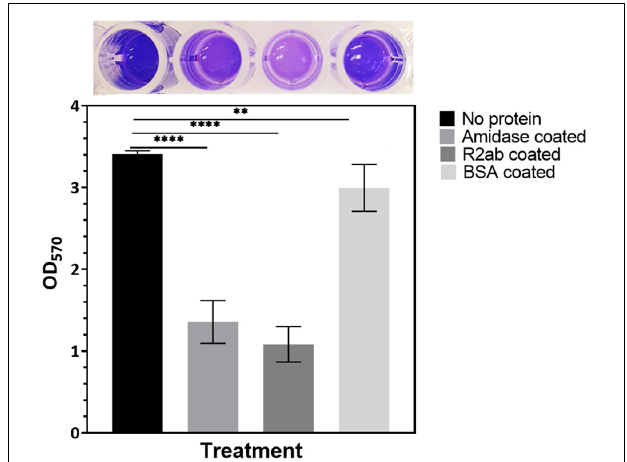
FIGURE 1 | The effect of protein treatment on biofilm formation. Wells were pre-coated with either no protein (control), amidase, R2ab, or BSA, followed by growth conditions favoring biofilm formation, which was monitored by crystal violet staining and measurement of absorbance at 570 nm. The BSA-coated plate showed only a slight reduction in biofilm growth relative to no treatment, but plates treated with amidase and R2ab domains show a much larger reduction. A typical row from a stained, 96-well plate is shown above each corresponding column to display the results of crystal violet staining. The error bars for each data point represent the standard error of the mean for N = 8 samples. A one-way ANOVA test [ F (3,28) = 217.2, p < 0.0001] with Tukey’s post hoc analysis was performed to determine the levels of significance (** p < 0.005, **** p <